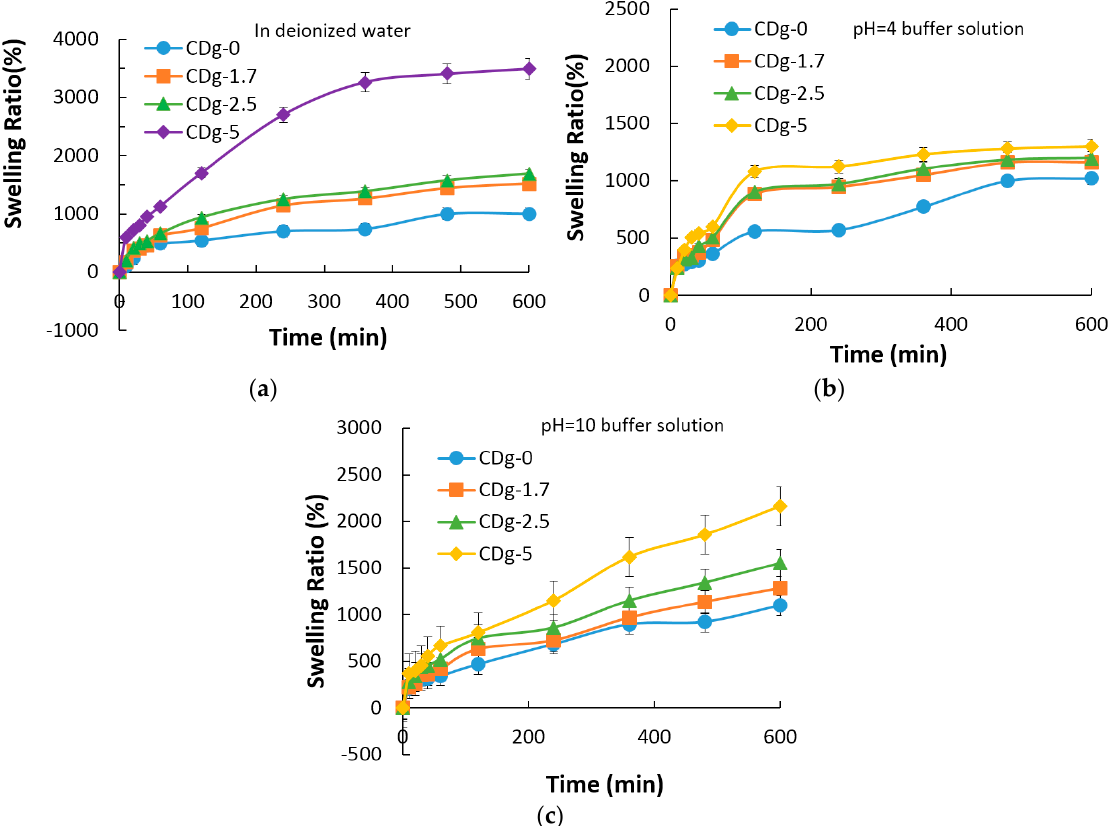
Figure 10. Swelling ratio vs. time curves for hydrogels: ( a ) in deionized water; ( b ) in the pH 4 buffer solution; and ( c ) in the pH 10 buffer solution with a time span up to 600 min.